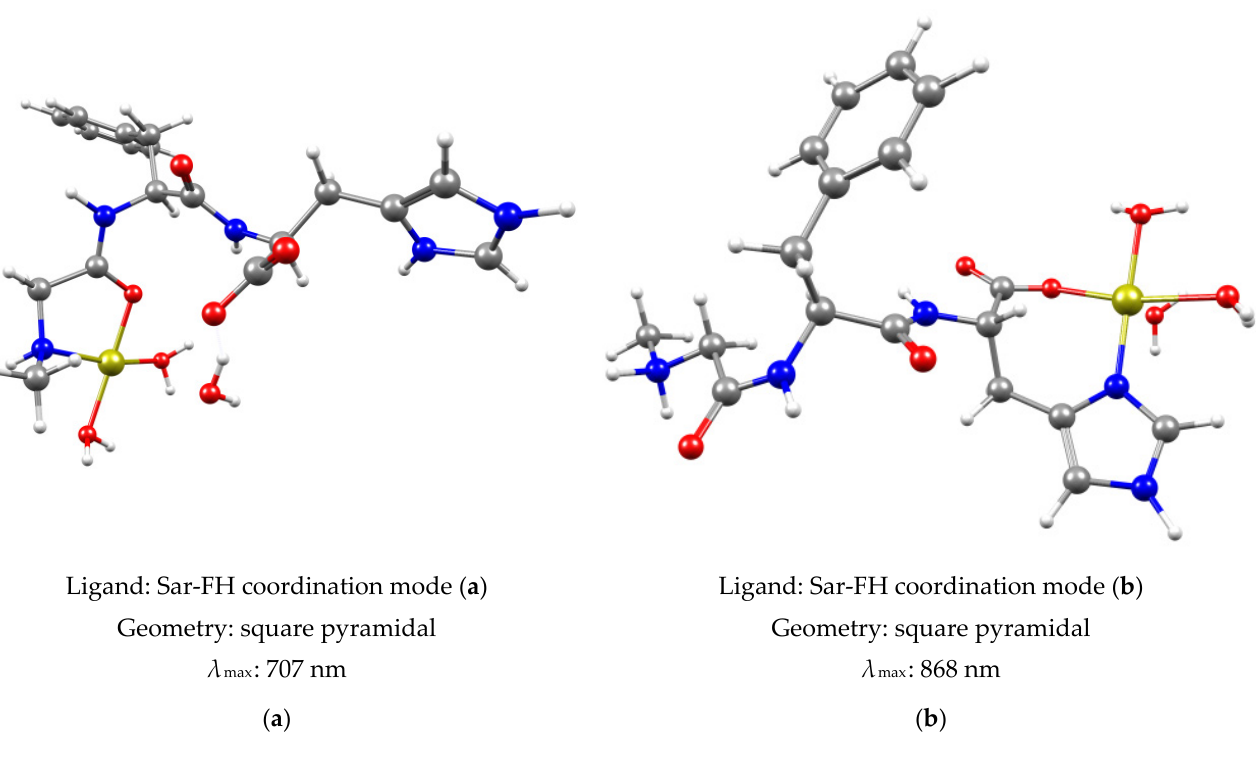
Figure 12. Visual representation of the proposed structures for the MLH species of ( a ) Cu-GLH, ( b ) Cu-Sar-LH, Cu-GFH and Cu-Sar-FH, as well as their geometries and calculated λ max obtained at B3LYP/6-31++G ** in water.